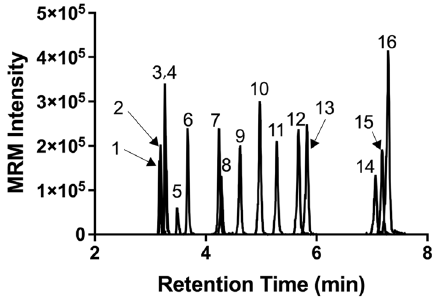
Figure 2. UPLC-MRM chromatograms of SIL heavy signature peptides for subcellular organelle marker proteins and three case study proteins. 1: HSC70_ITITNDK (Cytosol); 2: GRP78_ITITNDQNR (ER); 3: β2M_IQVYSR; 4: HSP60_VTDALNATR (Mitochondria); 5: HistoneH3.1_YRPGTVALR (Nucleus); 6: GRP78_LTPEEIER (ER); 7: LAMP1_TVESITDIR (Lysosome); 8: HSP60_LSDGVAVLK (Mitochondria); 9: CYP3A4_EVTNFLR; 10: Rab7_VIILGDSGVGK (Late endosome); 11: LAMP1_VWVQAFK (Lysosome); 12: Rab7_ATIGADFLTK (Late endosome); 13: Rab5_LVLLGESAVGK (Early endosome); 14: LAMP1_AFSVNIFK (Lysosome); 15: HSC70_FEELNADLFR (Cytosol); 16: FcRn_LFLEAFK.